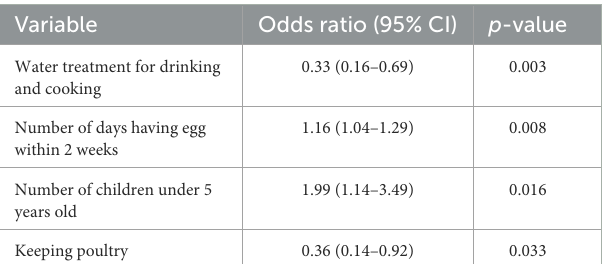
TABLE 4 Factors included in the final model of multivariable analysis for diarrhea using